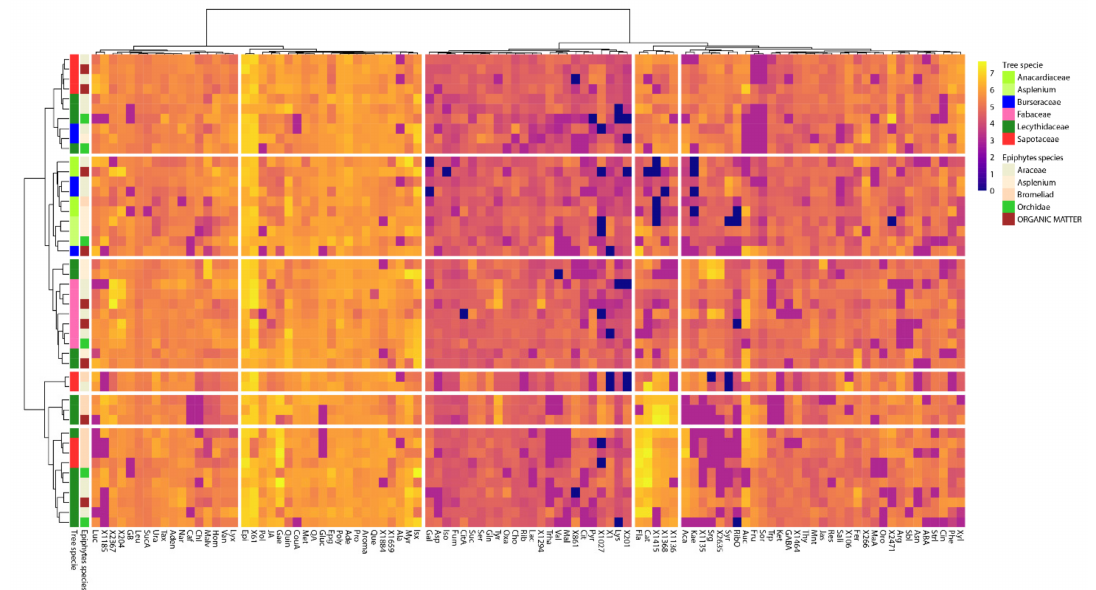
Figure 4. Heatmap clustering analysis of the metabolites identified in the foliar metabolomes of tree species and epiphyte species. Families and species are generally clustered together with the corresponding metabolites. The samples are represented horizontally, and the metabolites are represented vertically. Abundance is represented by the intensity of the color of each metabolite, with blue representing low abundance and yellow representing high abundance. The 100 most important metabolites that were differentially affected ( p < 0.05) between species and family are represented.